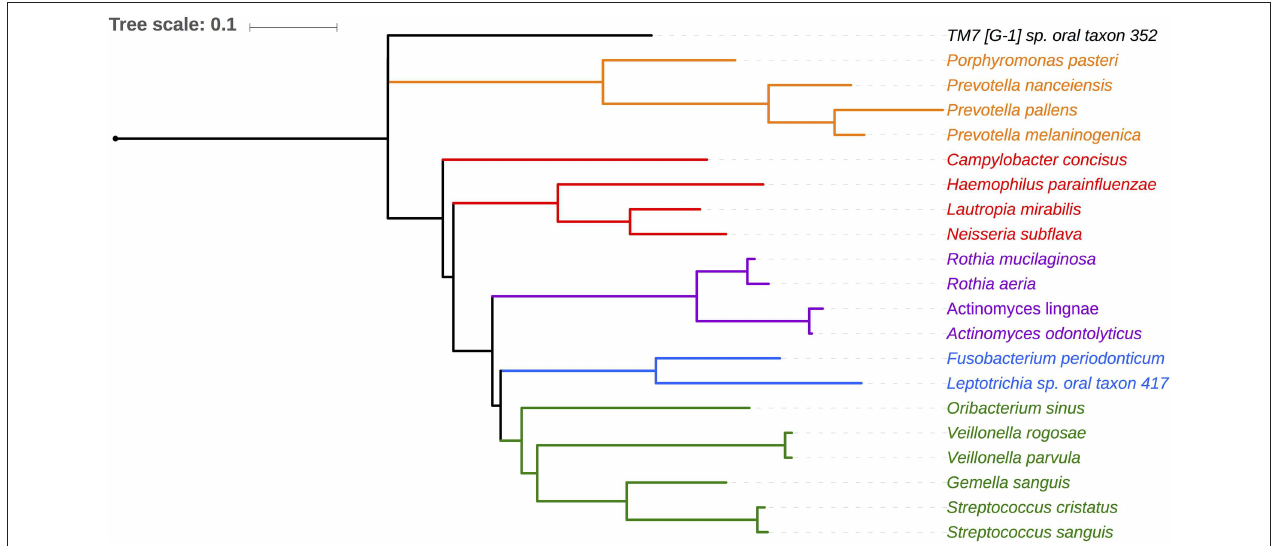
FIGURE 2 | Phylogenetic relationship of 21 species shared by 80% of the subjects. Phylotypes assigned to single HOMD entity are shown. Five phylotypes assigned to multiple species are not shown ( Granulicatella multispecies spp49 2, Streptococcus, multispecies spp1 2, Streptococcus multispecies spp24 14, Streptococcus multispecies spp32 2